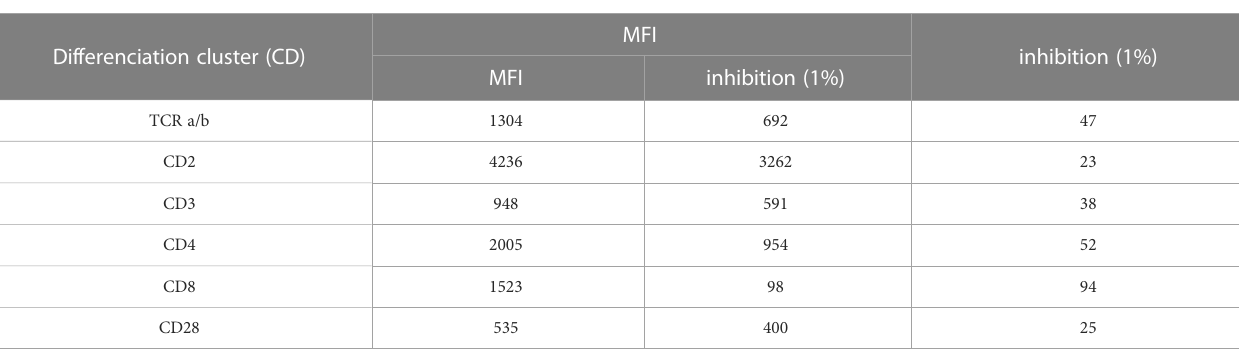
TABLE 1 Antigenic